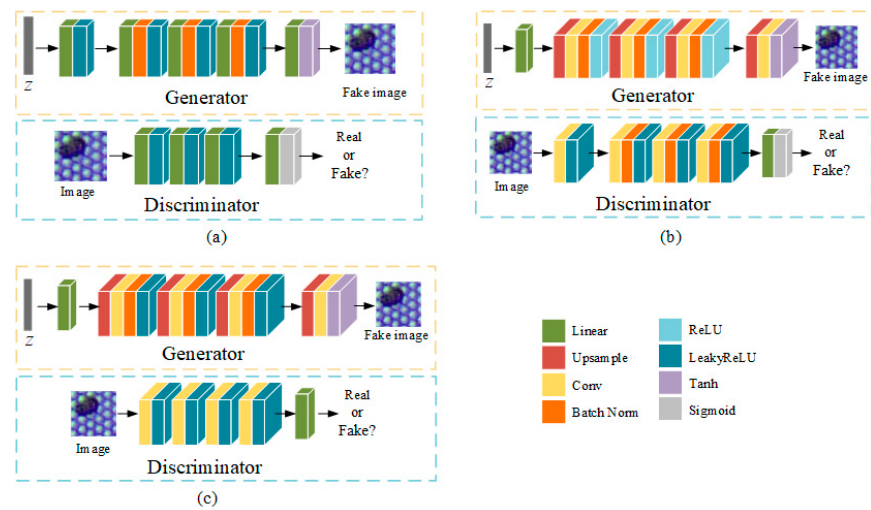
Figure 3. Different network structures of GAN variants: ( a ) GAN or WGAN with MLP; ( b ) deep convolutional GAN (DCGAN); ( c ) WGAN with deep convolutional structure (DC).